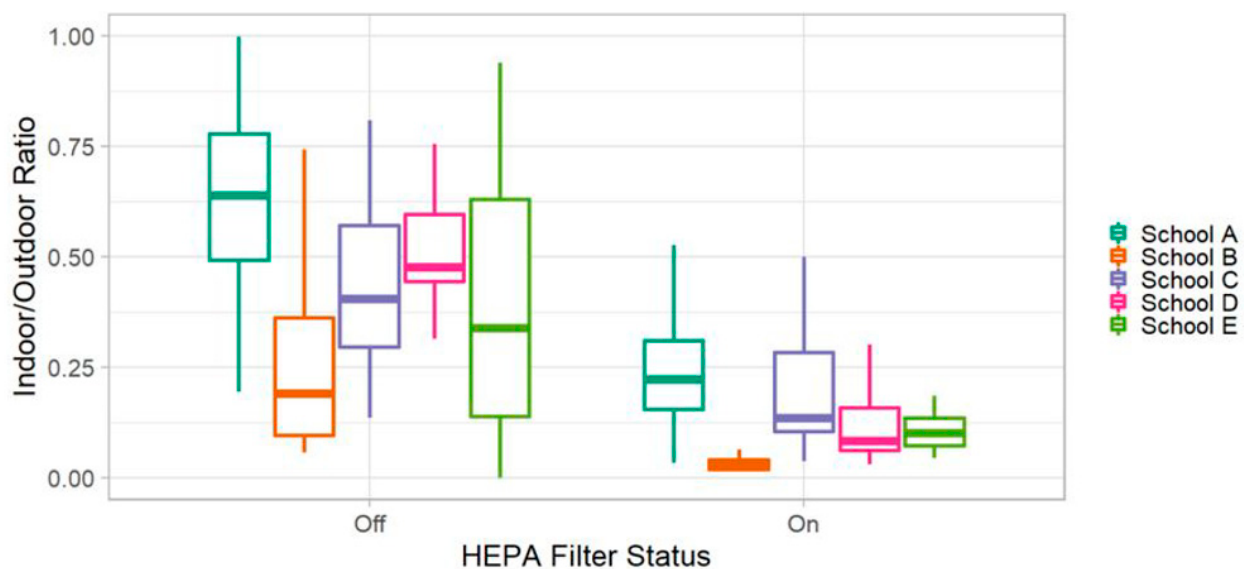
Figure 8. Distribution of indoor/outdoor ratio values for UFPs at each school location. Values were computed on the 30-min timescale. In the boxplots, the upper whisker represents the maximum, the top of the box represents the 75th percentile, the middle line represents the median or 50th percentile, the bottom of the box presents the 25th percentile, and the lower whisker represents the minimum.